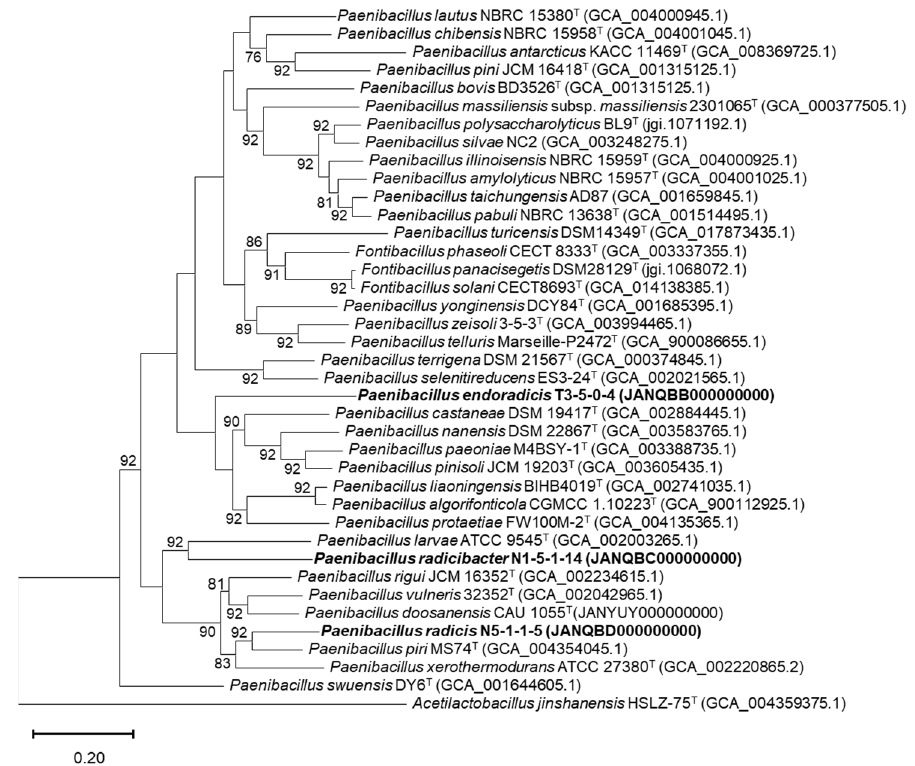
Figure 3. Phylogenetic tree based on the whole genome sequences showing the position of strains T3-5-0-4, N1-5-1-14, N5-1-1-5 and representatives of some related type strians in the genus Paenibacillus . The tree was constructed on concatenated alignment of 92 core genes ( alaS, argS, aspS, cgtA, coaE, cysS, dnaA, dnaG, dnaX, engA, ffh, fmt, frr, ftsY, gmk, hisS, ileS, infB, infC, ksgA, lepA, leuS, ligA, nusA, nusG, pgk, pheS, pheT, prfA, pyrG, recA, rbfA, rnc, rplA, rplB, rplC, rplD, rplE, rplF, rplI, rplJ, rplK, rplL, rplM, rplN, rplO, rplP, rplQ, rplR, rplS, rplT, rplU, rplV, rplW, rplX, rpmA, rpmC, rpmI, rpoA, rpoB, rpoC, rpsB, rpsC, rpsD, rpsE, rpsF, rpsG, rpsH, rpsI, rpsJ, rpsK, rpsL, rpsM, rpsO, rpsP, rpsQ, rpsR, rpsS, rpsT, secA, secG, secY, serS, smpB, tig, tilS, truB, tsaD, tsf, uvrB, ybeY, and ychF ). Bootstrap values are shown at branching nodes. Bar, 0.2 substitutions per nucleotide position.